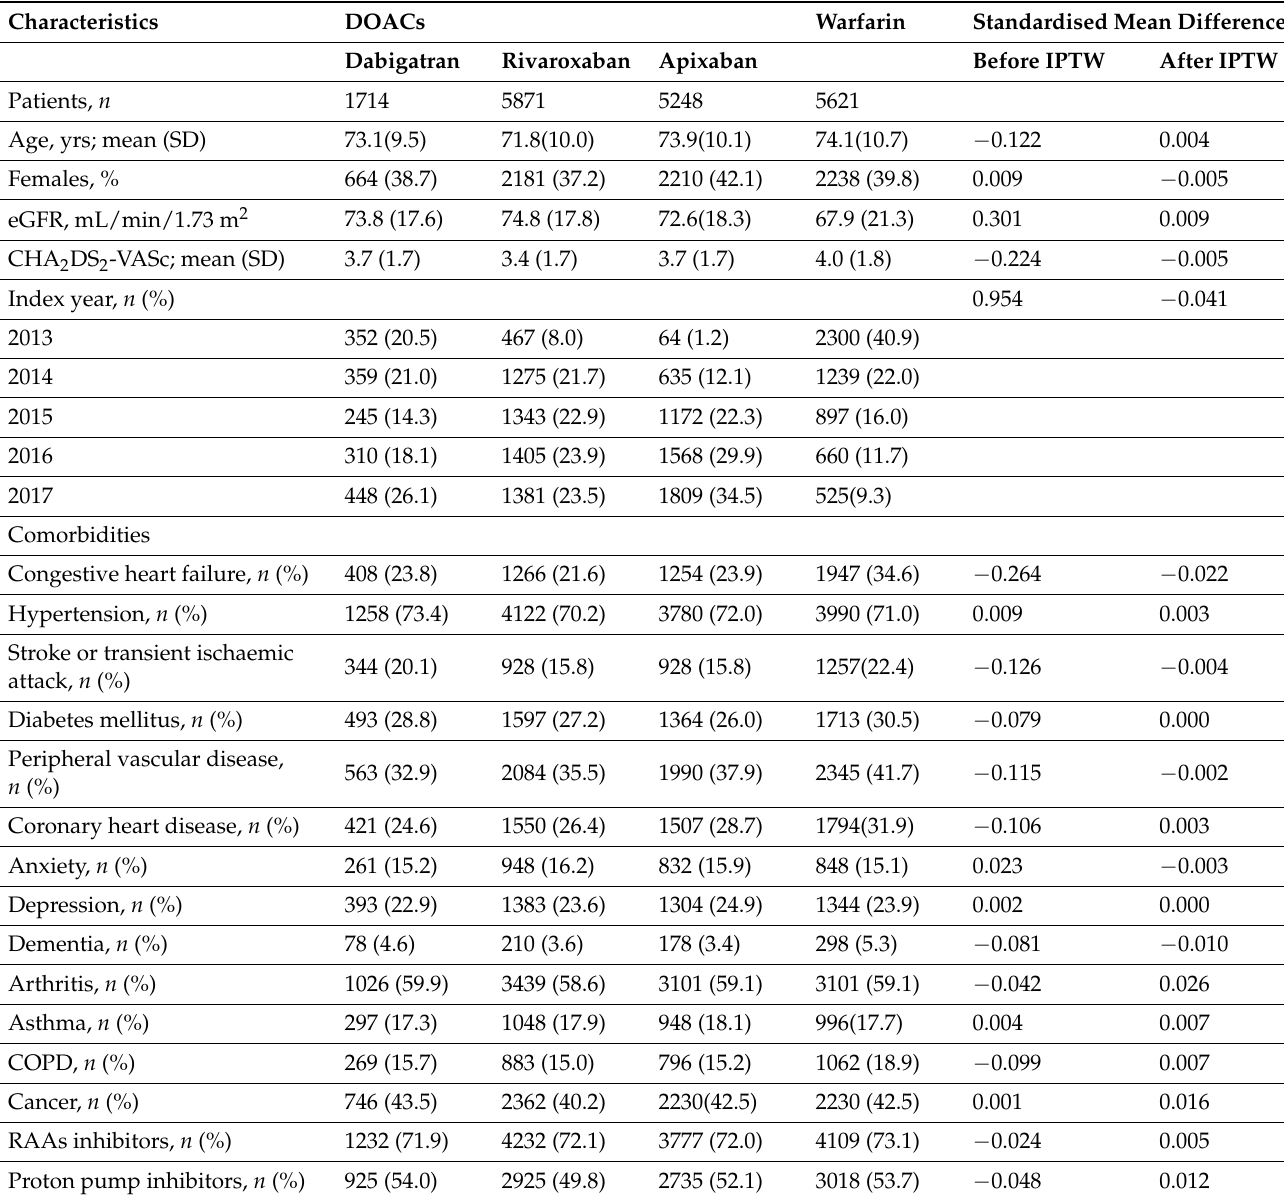
Table 1. Baseline